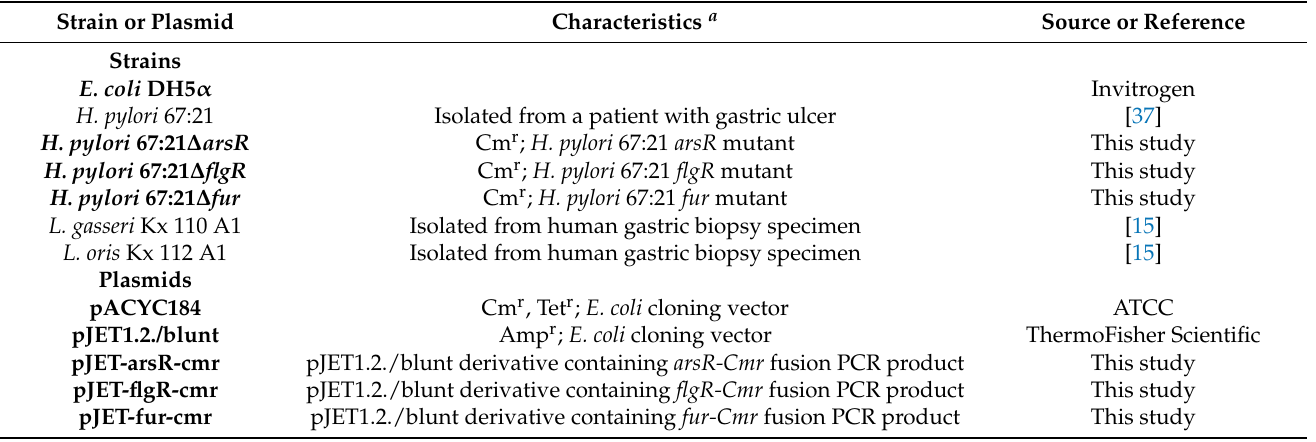
Table 1. Bacterial strains and plasmids used in this